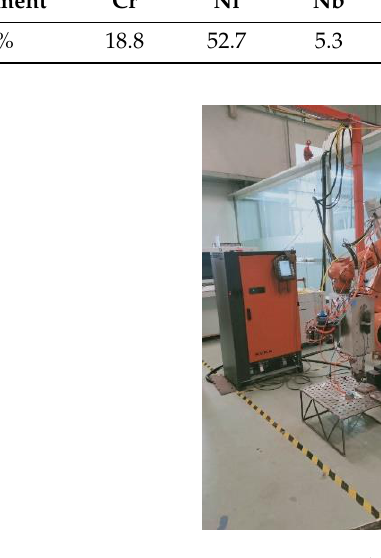
Figure 1. XRD patterns of La 2 Zr 2 O 7 powder. Table 1. Chemical composition of the experimental GH4169 alloy.